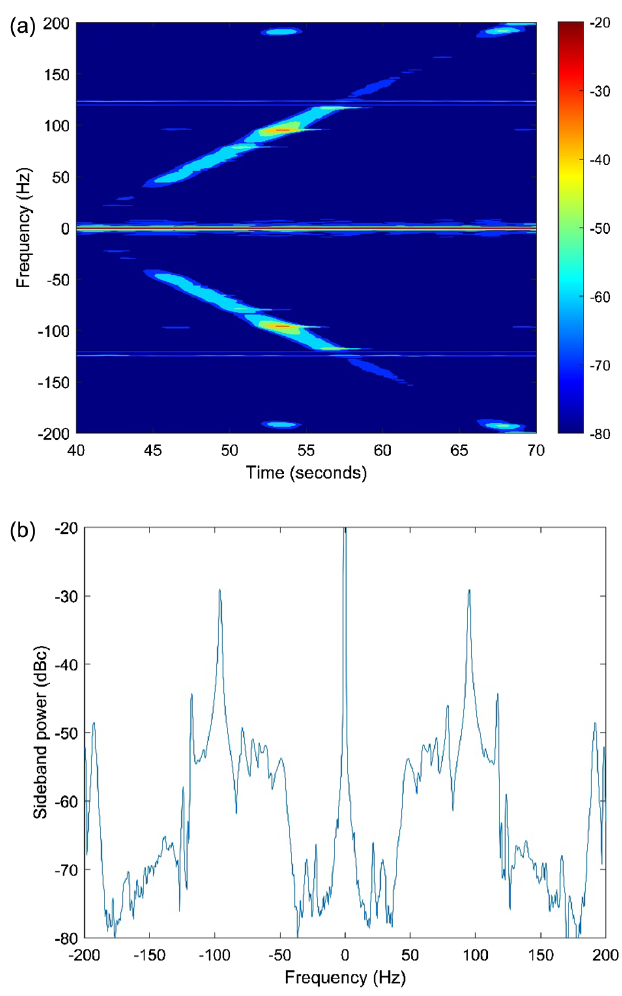
FIG. 8. (a) The spectrogram with the mechanical mode scan. Sinusoidal vibrations were excited and its frequency was swept from 20 to 200 Hz. The color map represents the sideband power in units of dBc. (b) The integrated spectrum. The dominant electromechanical resonance is at 96 Hz, with a response at least 15 dB stronger than any other mode.